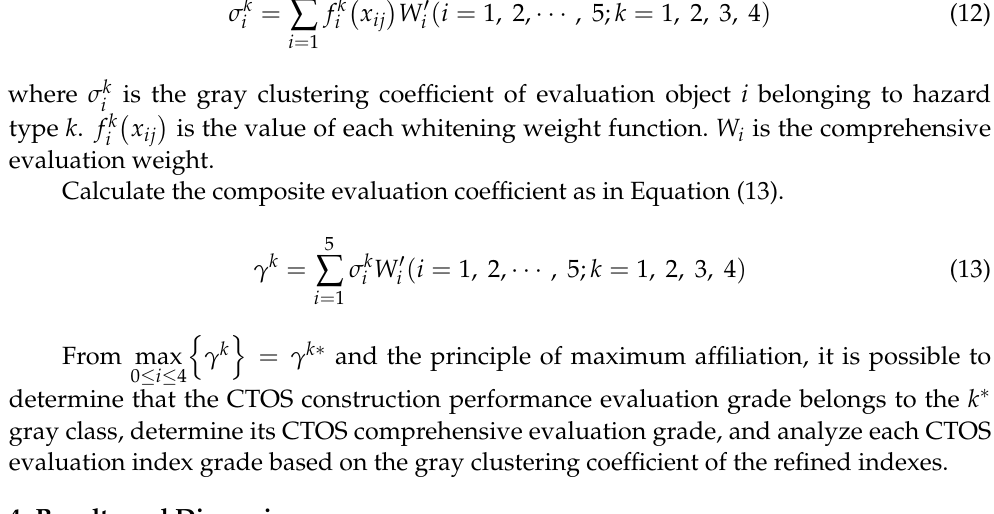
Figure 4. Directed topology flow chart.